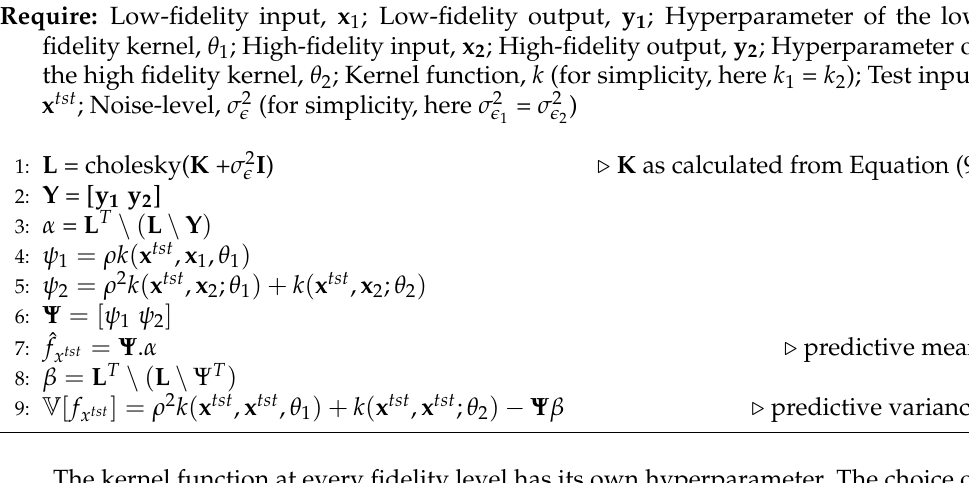
Algorithm 1 Multi Fidelity Gaussian